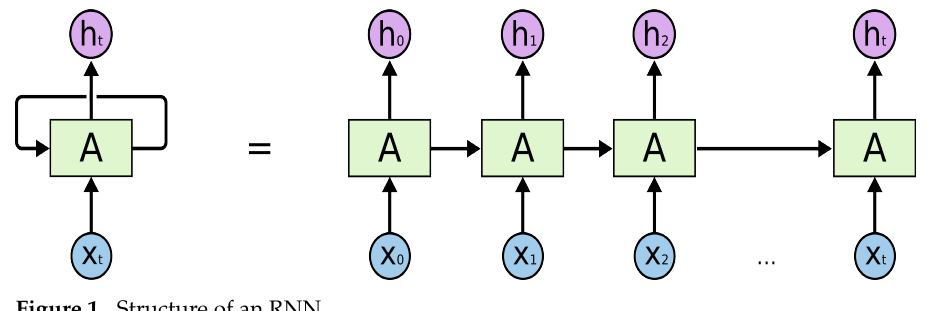
Figure 1. Structure of an